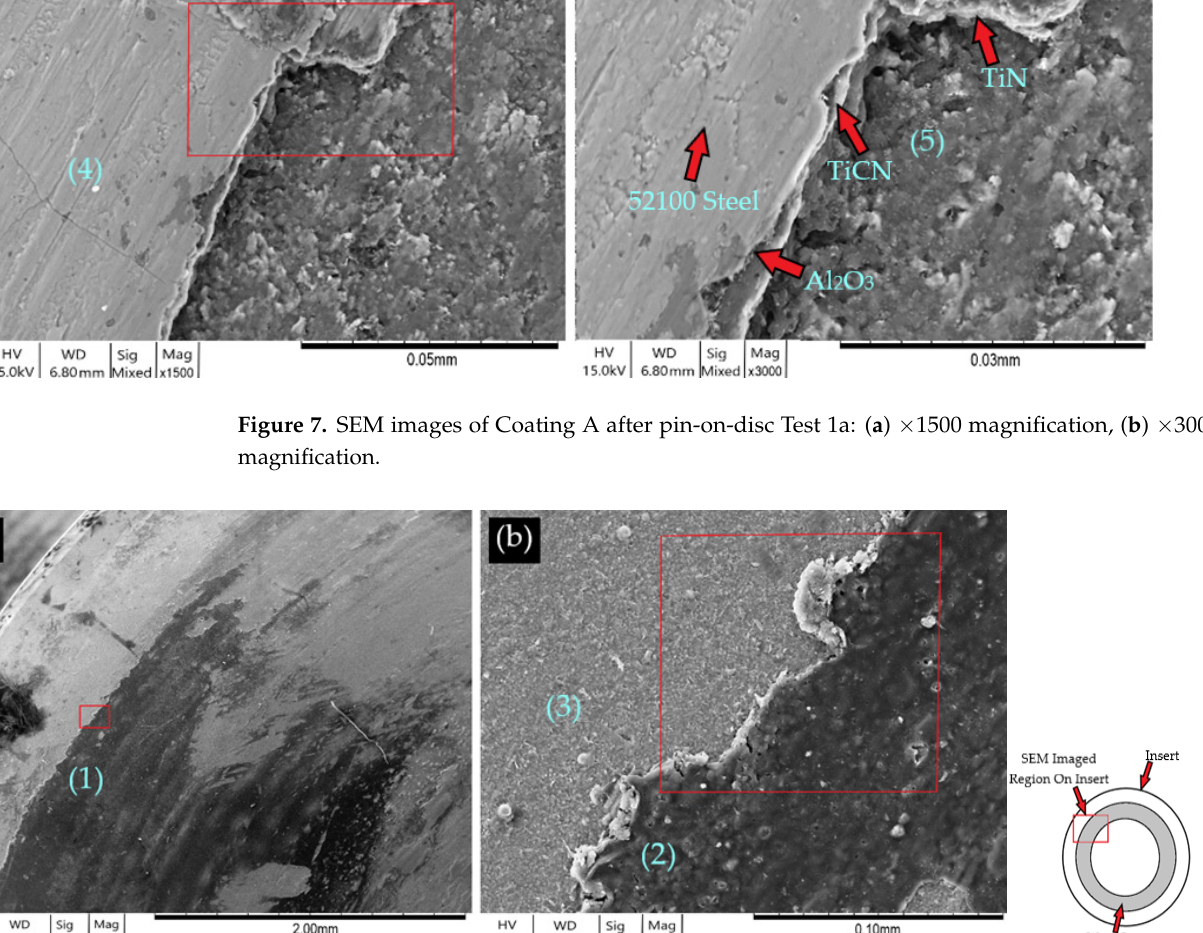
Figure 8. SEM images of Coating B after pin-on-disc Test 1b: ( a ) ×50 magnification, ( b ) ×800 magni- Figure 8. SEMimagesofCoatingBafterpin-on-discTest1b: ( a ) × 50magnification, ( b ) × fication.